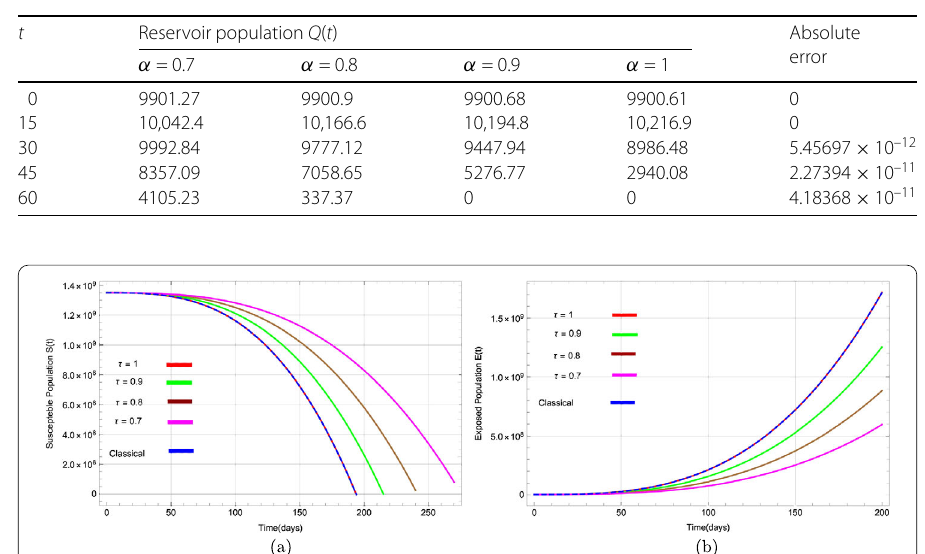
Table 7 Numerical results of reservoir population Q ( t ) for fractional parameter τ = 0.7,0.8,0.9,1 and comparison between classical and approximate solution